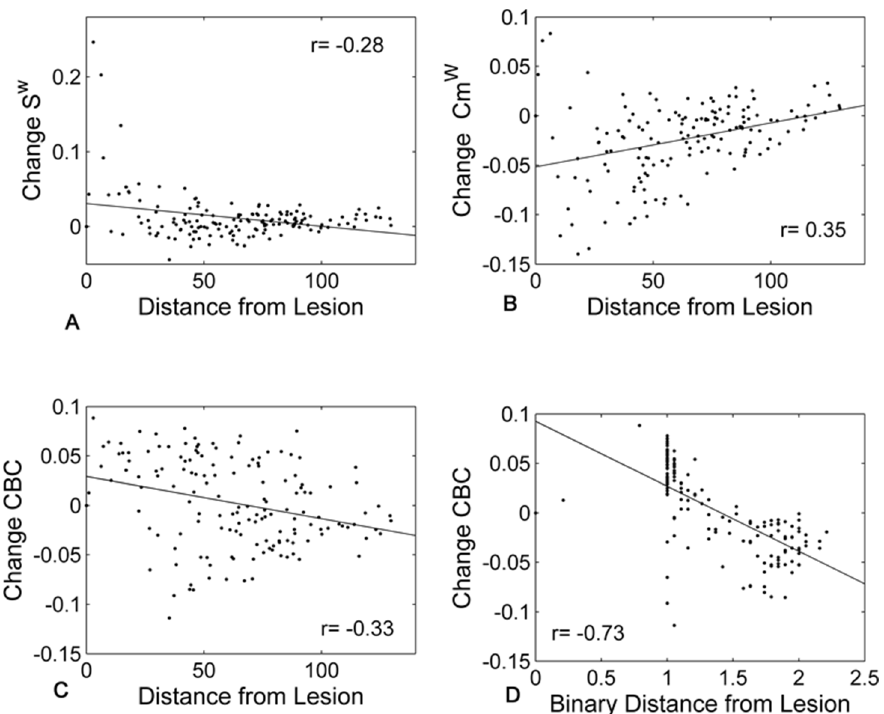
Fig. 5. Relationship between the average local changes over subjects and the distance from the lesion site (after 5 attacks to hubs nodes). Each dot in the figure represents a node in the average network. A positive change indicates a reduction in the metrics after the lesions. Scatter plots are reported for S w (A), Cm w (B) and CBC (C) against weighted distance and for CBC against binary distance